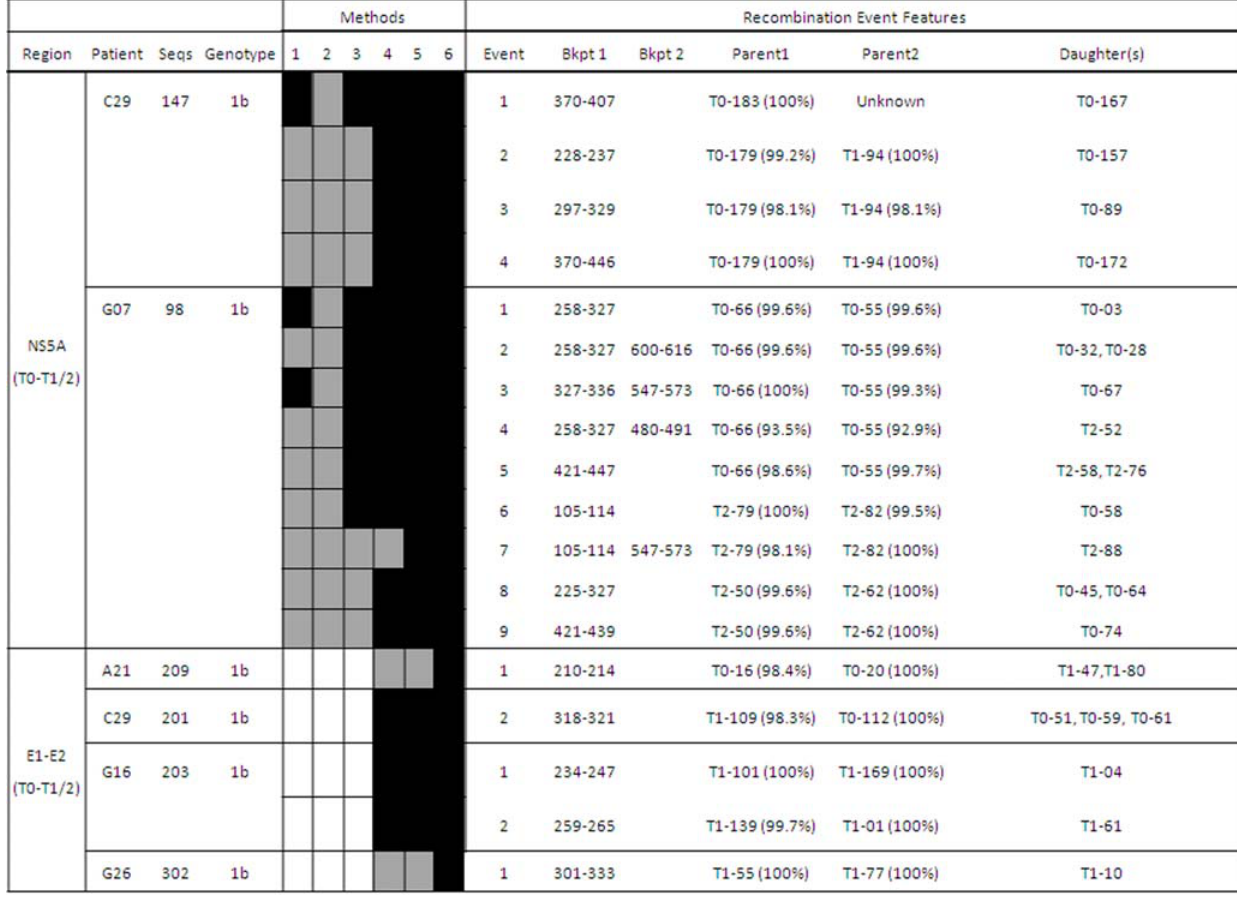
Figure 4. Summary of the joint analysis of two time-point samples from the same patients resulting in positive detection of recombination. See further details in legend to Figure 1.